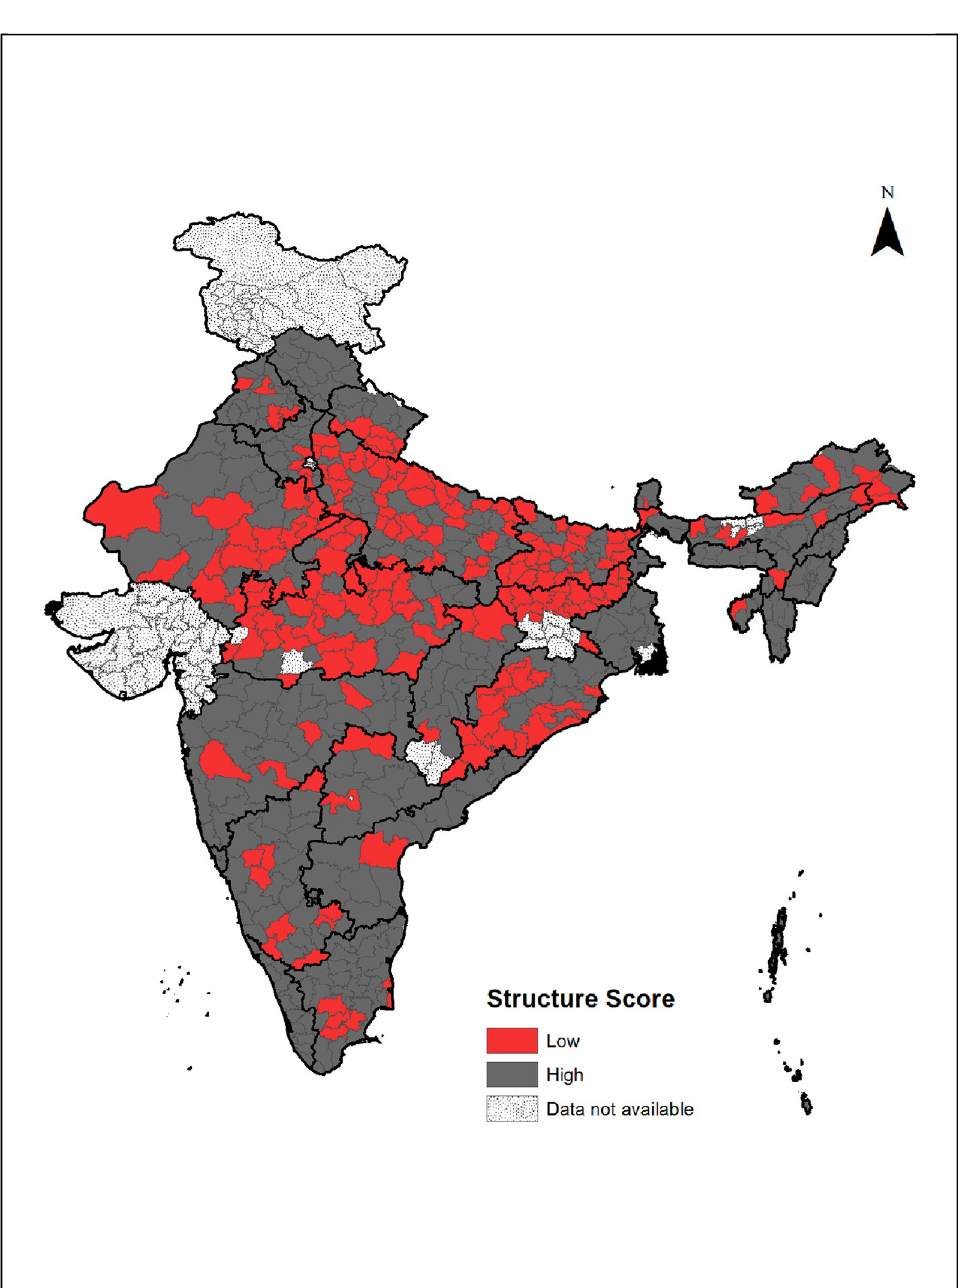
Fig 3. District-wise distribution of ‘low’ structure score indicating the availability of infrastructure and readiness at the public health facilities in India, DLHS facility survey 2012–13.